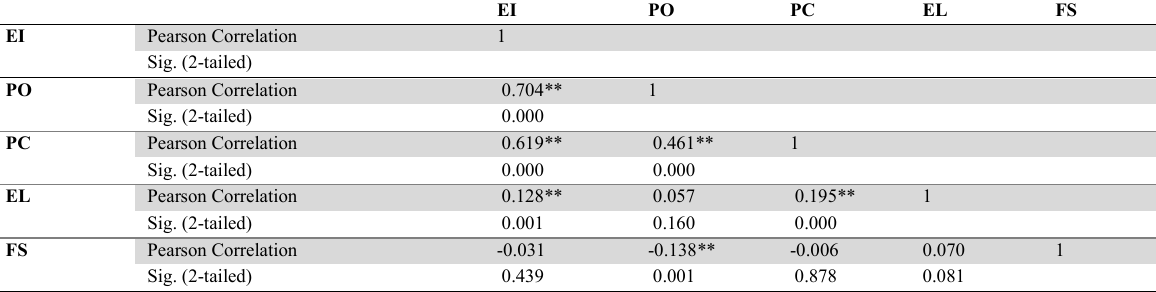
Correlation coefficients between